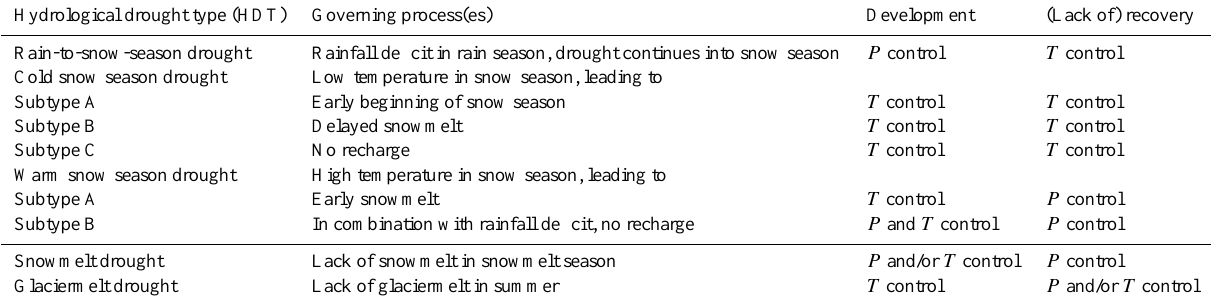
Table 1. Drought propagation processes (including development and recovery) per temperature-related hydrological drought type and subtype (adapted from Table 8.1 of Van Loon, 2013, and including new types). P = precipitation and T = air temperature. Hydrological drought type (HDT)